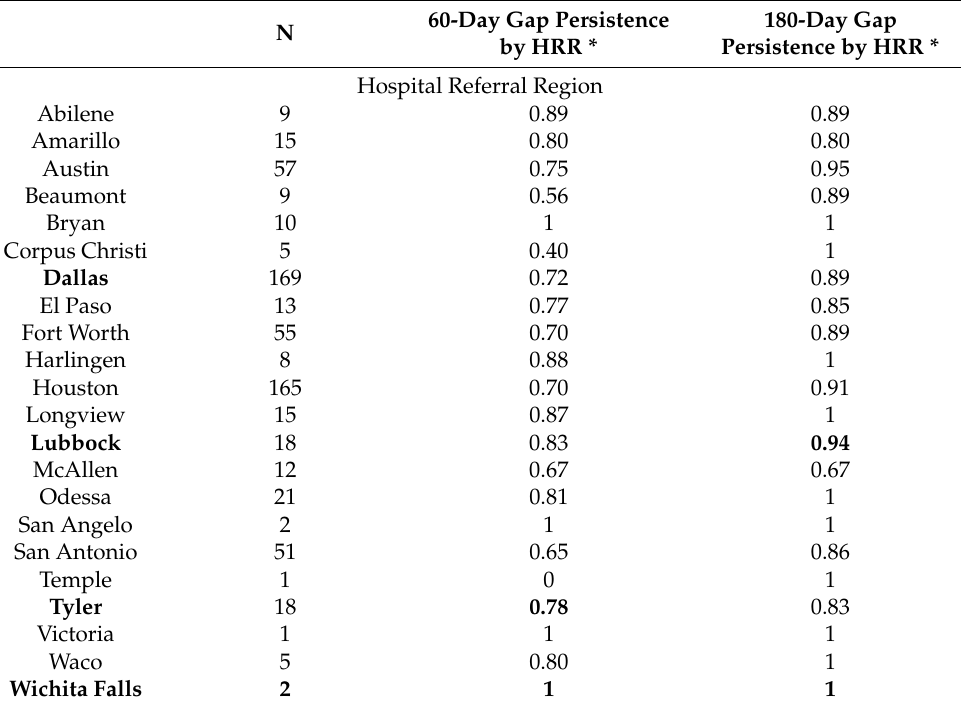
Table A1. Mean AHT persistence by HRR, by length of treatment gap.